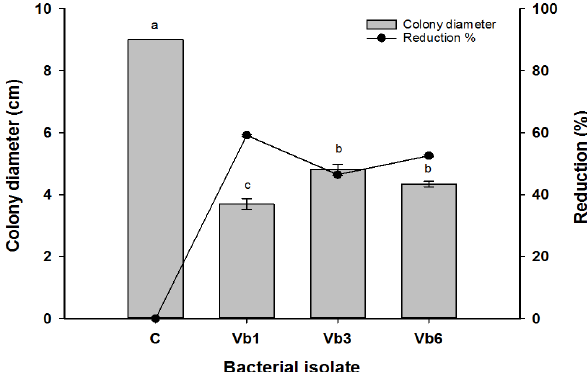
Figure 1: Antagonistic activity of the most potent bacterial isolates Vb1, Vb3, and Vb6 against highest pathogenic F. oxysporum strain by in-vitro dual culture assay. Bars with the different letters are significantly different ( p ≤ 0.05). Error bars indicate means ± SE ( n =